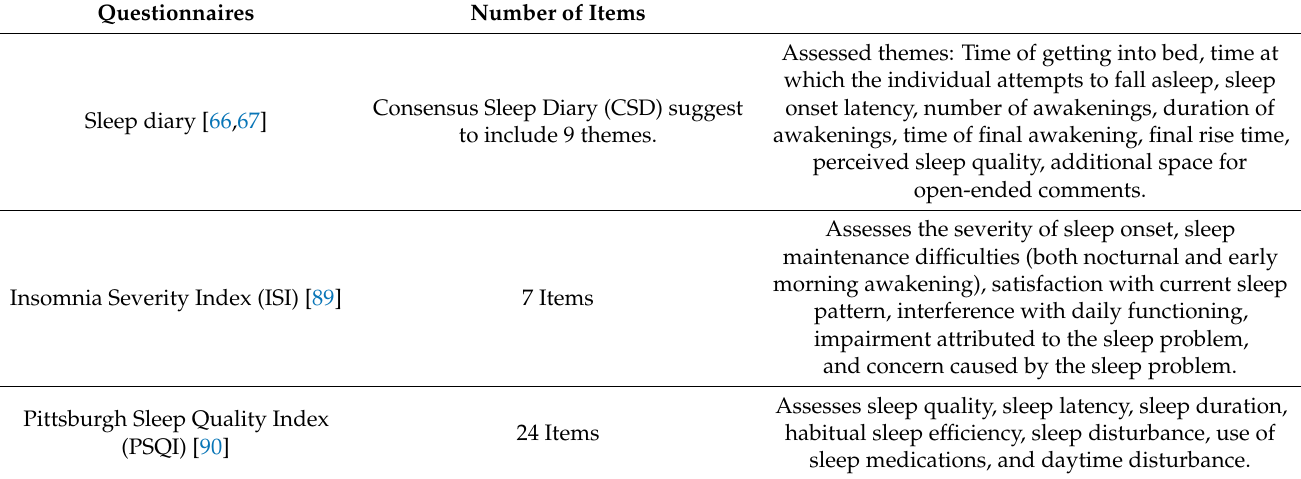
Table 2. Examples of questionnaires to evaluate sleep quality pre- and